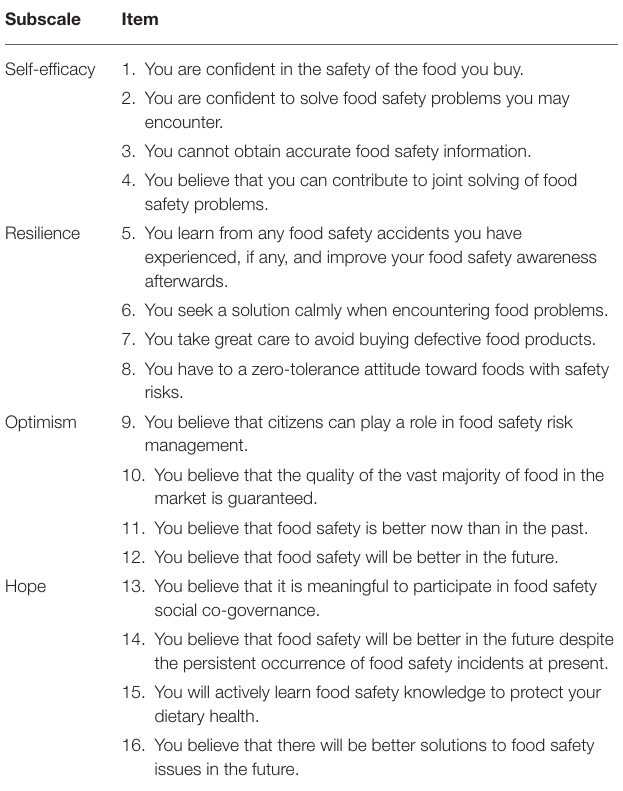
TABLE 1 | Scale for PsyCap of citizens in food safety social